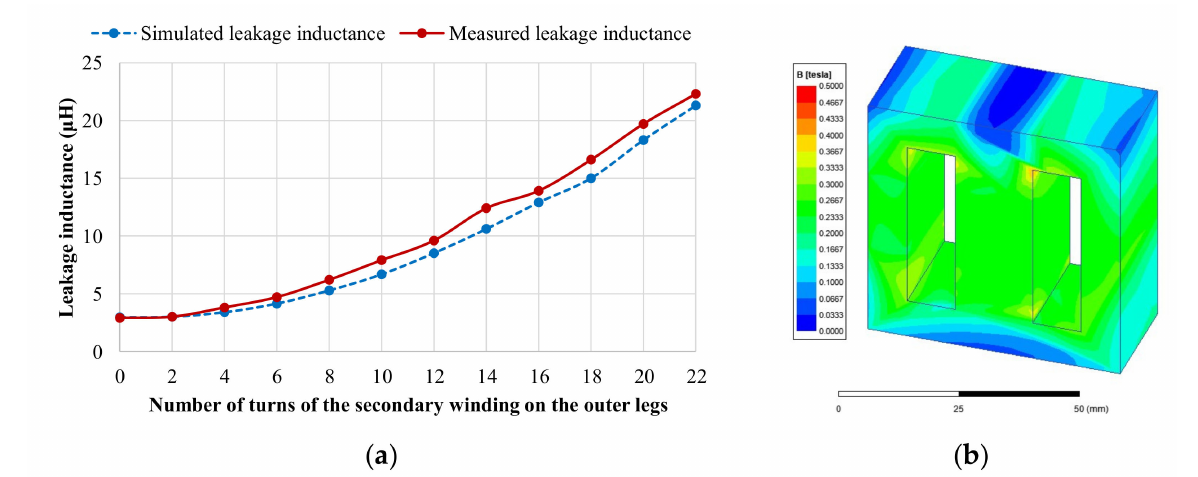
Figure 12. Finite Element Analysis (FEA) simulation result. ( a ) Relationship between the number of turns of the secondary winding on the outer legs and the leakage inductance. ( b ) The magnetic flux density distributions of the core.